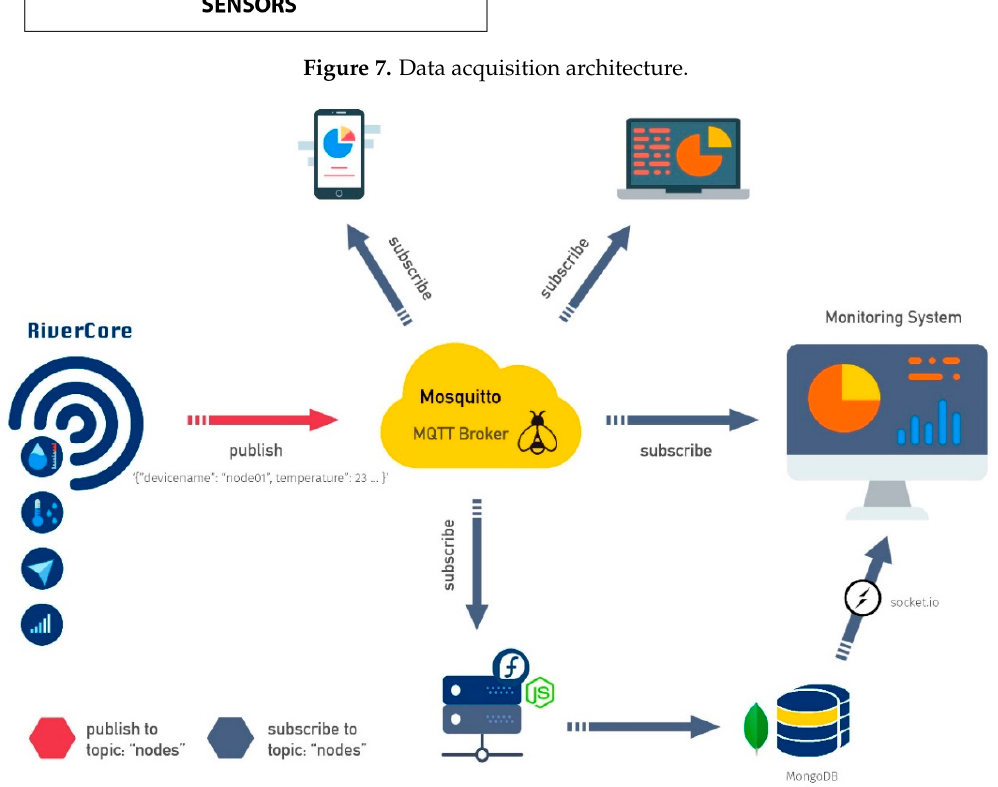
Figure 7. Data acquisition architecture.